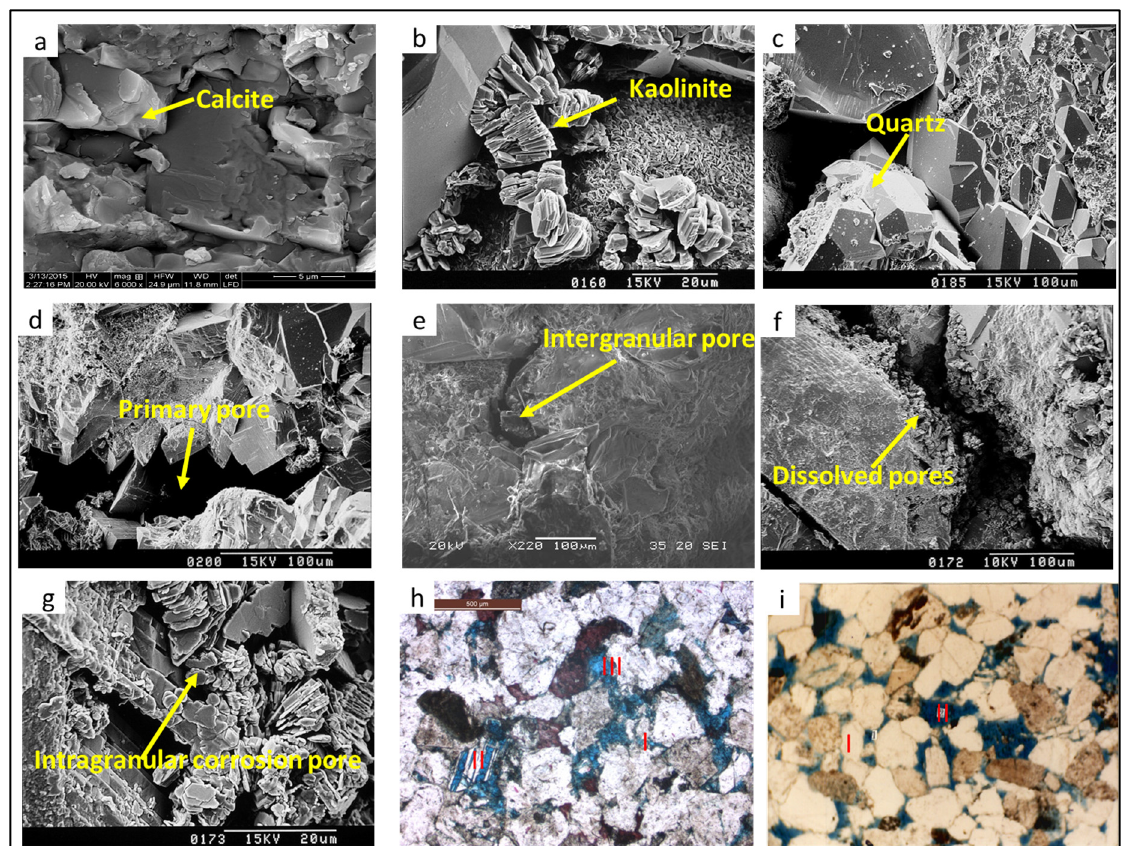
Figure 15. Typical images of the scanning electron microscope (SEM) and casting thin sections. ( a ) Calcite, Well B, 4811.76 m. ( b ) Kaolinite, Well D, 2931.57 m. ( c ) Quartz, Well D, 3402 m. ( d ) Primary pore, Well D. ( e ) There are secondary elongated pores between particles, Well D, 3693.5 m. ( f ) Dis- solved pores in feldspar grain. ( g ) Mold pores filled with authigenic kaolinite, Well D, 3092.4 m. ( h ) I. Primary pores, II. feldspar pores, III. dissolved pores; Well B, 4794.86 m. ( i ) I. Primary pores, II. mold pores; Well D, 3405.29 m.